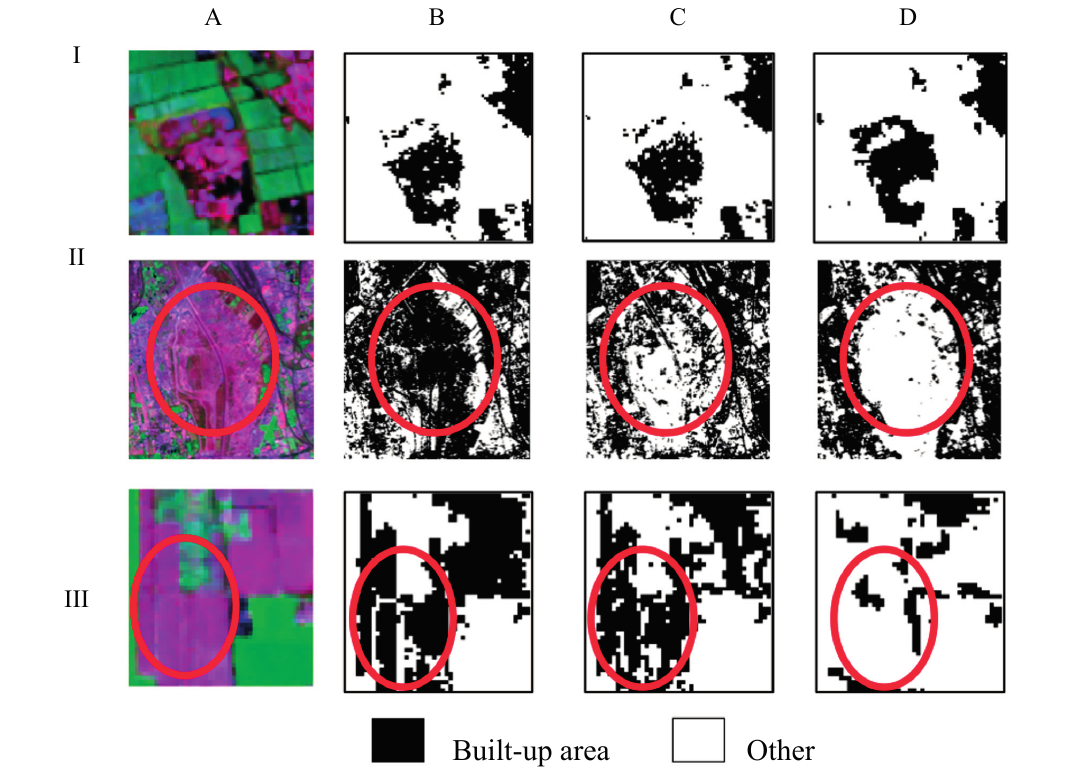
Figure 6. Portions of Landsat TM images (Bands 7, 4 and 2 as R, G and B) ( A ); I-A: built-up area (mostly in the middle, red color) and surrounding vegetated farmland; II-A: bare land (mostly in the middle, red color) and neighboring urban built-up area; III-A: harvested farmland (red color) and vegetation; corresponding classification results of different data combinations in Beijing area. ( B ) Spectral data alone; ( C ) spectral data and GLCM texture; ( D ) spectral data and variogram texture with spectral angle